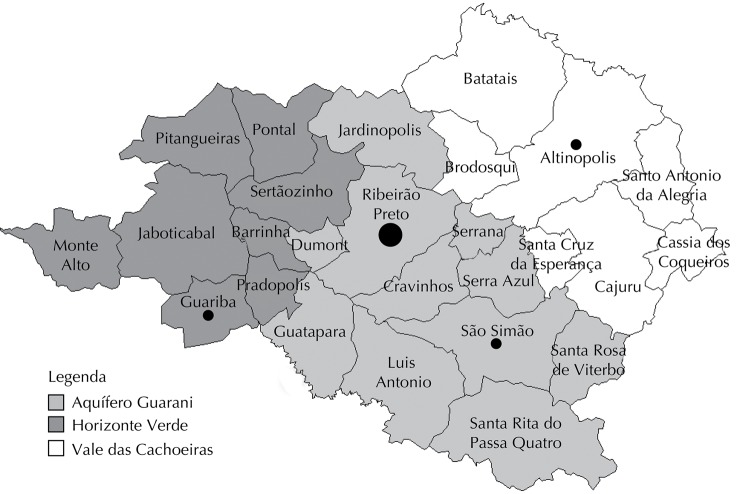
Municípios do Departamento Regional de Saúde XIII do Estado de São Paulo classificados quanto ao distrito. A esfera maior marca o município-pólo e as esferas menores, os municípios parceiros do projeto, mostrando sua localização estratégica para cada distrito.